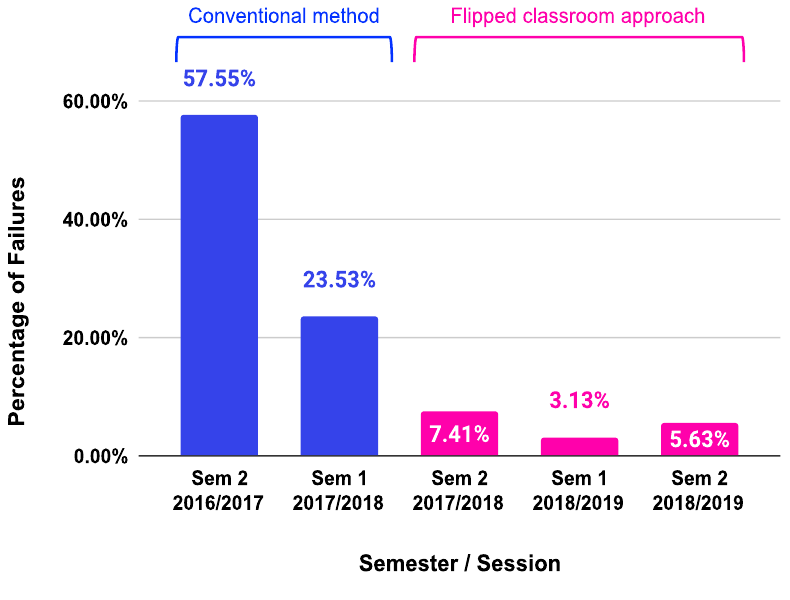
Fig. 1. The percentage of students failed in the